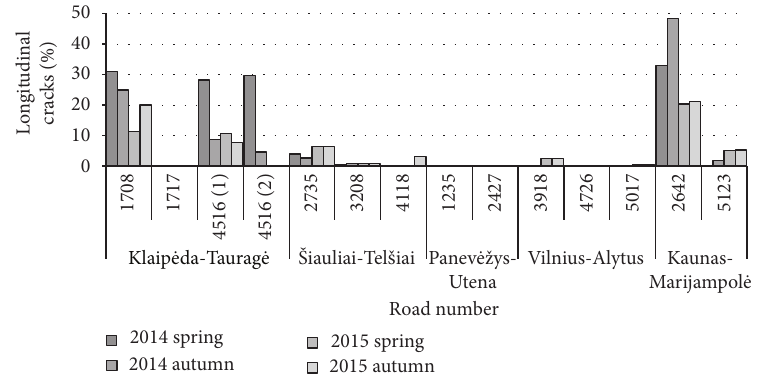
Figure 11: Longitudinal cracks on roads sections covered with double Otta Seal.